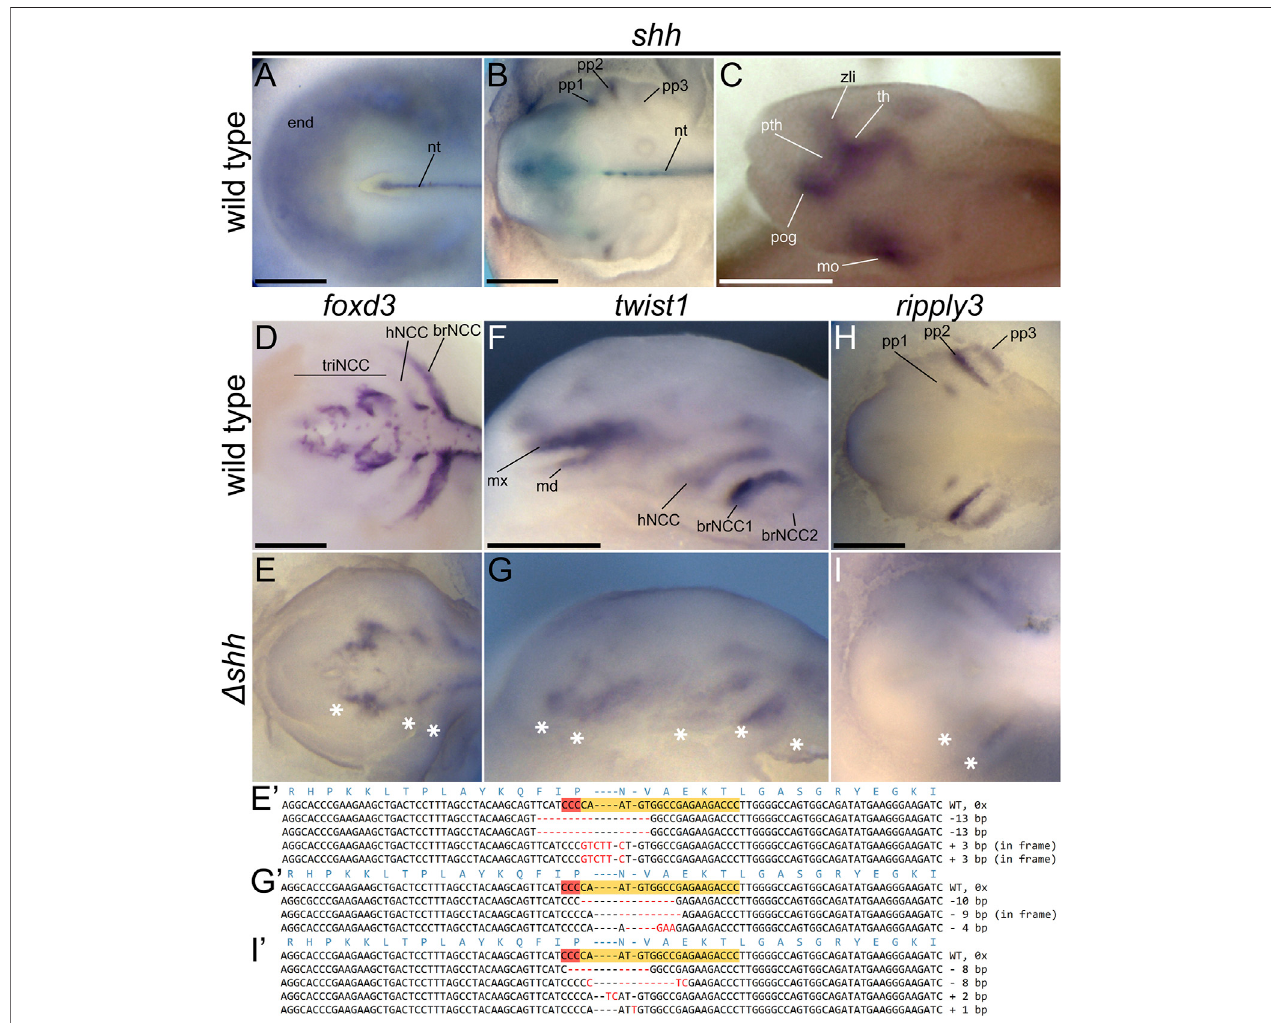
FIGURE 4 | shh expression patterns and Δ shh sterlet embryos at st. 28 showing defects in expression patterns of foxd3 , twist1 , and ripply3 . Dorsal (A,B,D,E,H,I) and lateral (C,F,G) viewswithanteriortotheleft. Patternsof shh expression in various morphologicalstructuresofthewild-type sterlet embryosat stages 23 (A) , 28 (B) , and 30 (C) . foxd3 marks neural crest cells (NCCs) at early stages of migration, twist1 marks NCC at later migration stages, and ripply3 is expressed in developing pharyngealpouches.Compare with Supplementary FigureS3 toseetheobservedvariationinexpression patternsinboth wild-type and mutant individuals. The sequencesshowthereverseDNAstrandswith shh sgRNAoneCRISPRtargetsiteshighlightedinorangewithredPAMsite.Thereddashesandlettersshowindelsand polymorphisms relative to the WT sequence. Asterisks indicate missing or reduced expression in mutant embryos. brNCC — branchial stream of NCCs, hNCC — hyoid stream of NCCs, md — mandibular stream of trigeminal stream of NCCs, mo — mouth, mx — maxillary stream of trigeminal stream of NCCs, nt — notochord, pog — pre- oralgut, pth — prethalamus,pp — pharyngealpouch,th — thalamus, triNCC — trigeminalstreamofNCCs, zli — zona limitans intrathalamica. Scalebars represent0.5 mm.